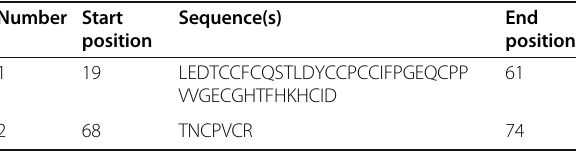
Table 3 Antigenic determinants of EhApc11. The table indicates the positions and sequences that might be associated with the antigenic propensity of EhApc11 Number Start